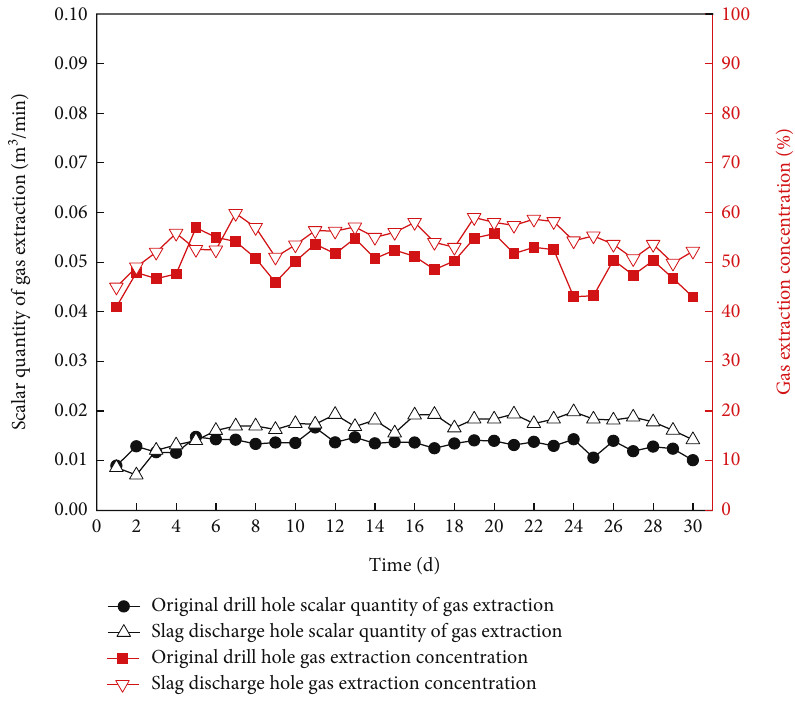
Figure 5: A comparison of extracted gas concentration and quantity of gas extraction in the shallow drill hole.